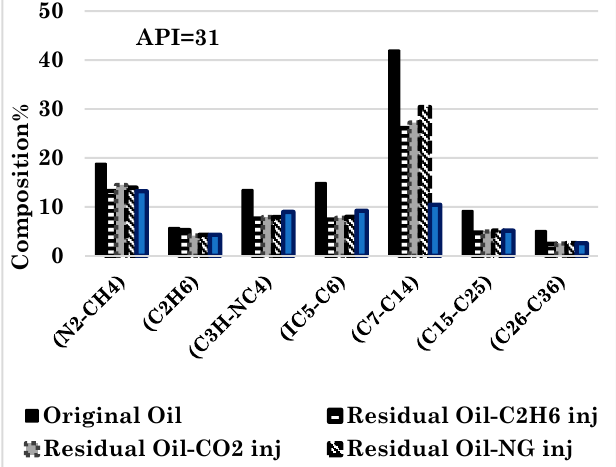
Figure 6. Composition of oil before and after natural depletion (ND) and CGI by CO2, C2H6 and